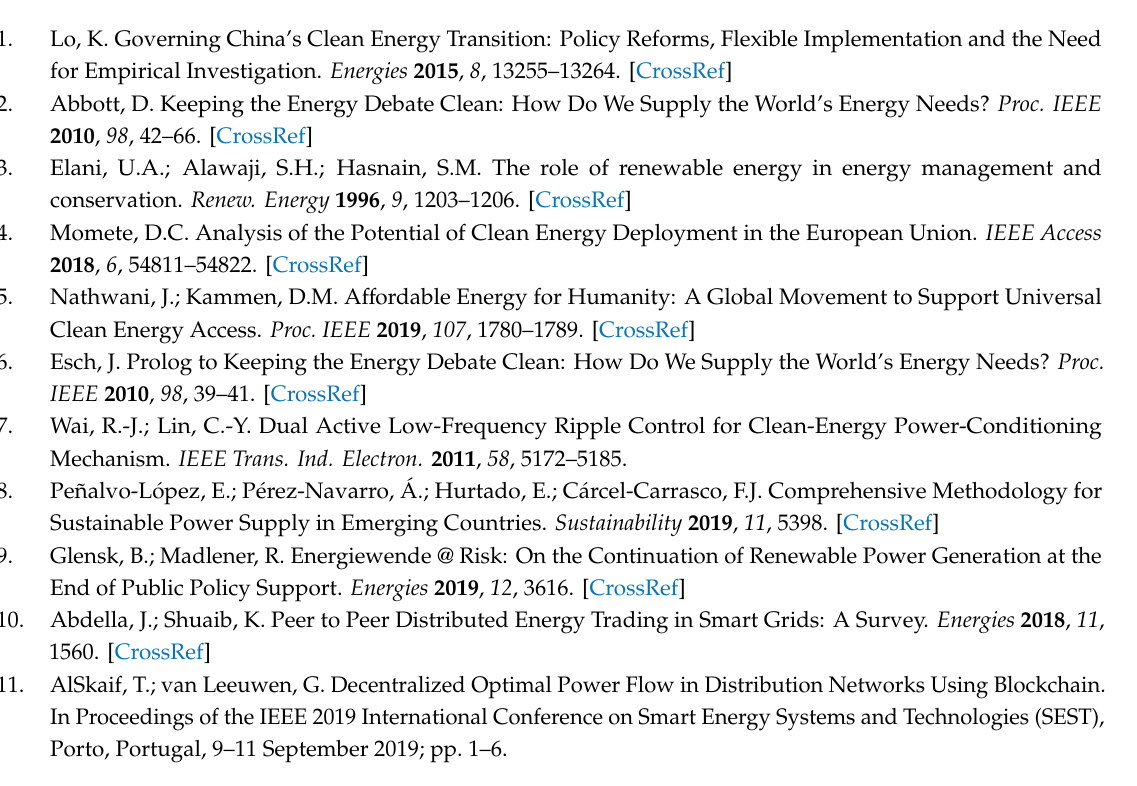
Figure A6. Chain110kV releasing scheduling data, and data asset information downloading.